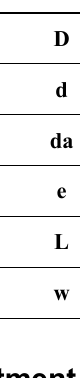
Table 1. Geometrical characteristics of the